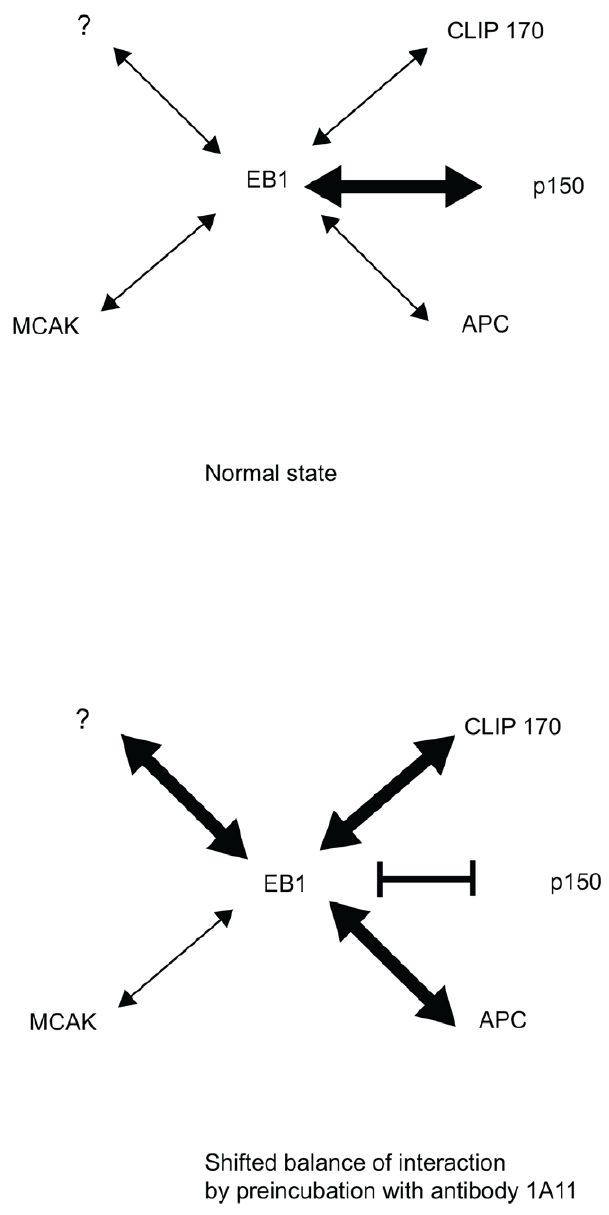
Figure 13. Diagram showing the possible interactions of EB1 with main interactants and the effect of antibody binding. Blocking of EB1 with 1A11 enhances some interactions (CLIP-170, APC), reduces interactions with p150Glued and has no effect on other interactions, for example with MCAK (shifted balance after preincuba- tion with specific